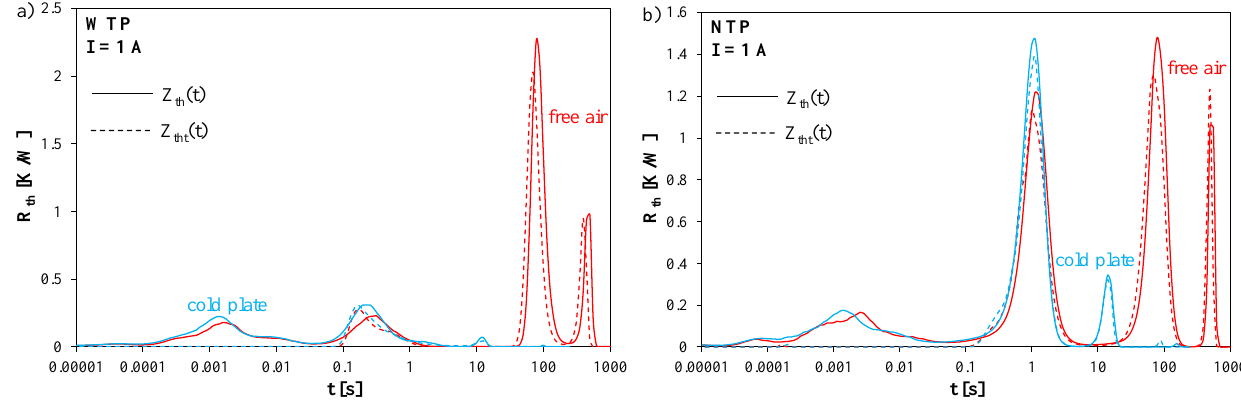
Figure 9. Measured waveforms of self (solid lines) and transfer (dashed lines) transient thermal impedances of the diodes contained in the MCE device WTP ( a ) and NTP ( b ) measured with the custom set-up.